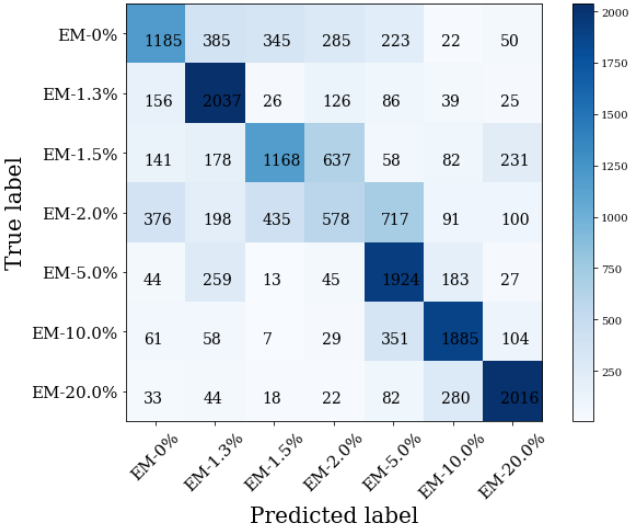
Figure 8. Class-specific diagnostics performance by DNN: confusion